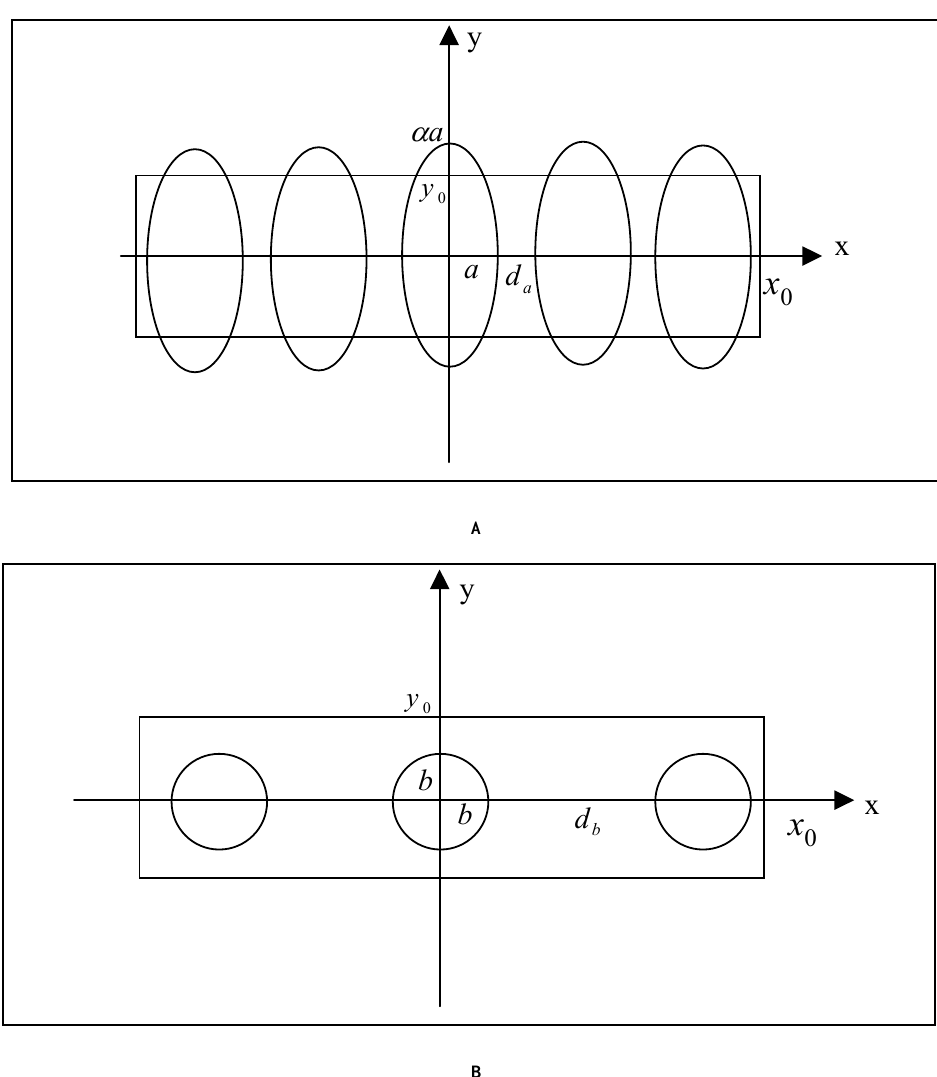
FIGURE 2. The simulations of gland and background regions. (A) Goblet cells in a row forming a piece of segment of a gland band. The shape of goblet cells are elliptical with long axis roughly trice as long as the short one. The cells sit well in parallel. (B) Nongoblet (endocrine or epithelial) cells loosely scattered in the background. The endocrine and epithelial cells have nearly round shape and sit loosely in distance from each